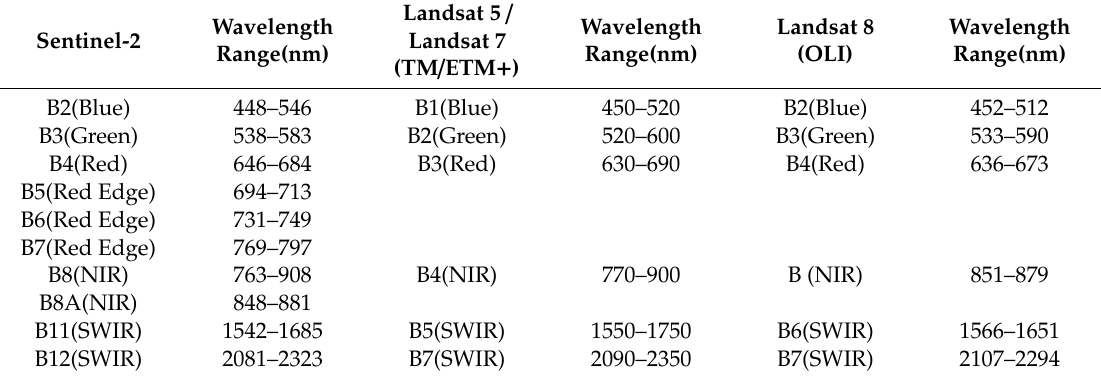
Table 2. Comparison of the Sentinel-2 (S-2) and Landsat bands used in the study. NIR is Near Infra-Red, SWIR is Short Wave Infra-Red, OLI is Operational Land Imager, TM is Thematic Mapper and ETM + is Enhanced Thematic Mapper Plus. All Landsat bands are 30 m resolution. For S-2 bands B2, B3, B4 and B8 are 10 m resolution while the others are 20 m. For S-2, wavelength ranges given are for satellite S-2A, the values for S-2B vary